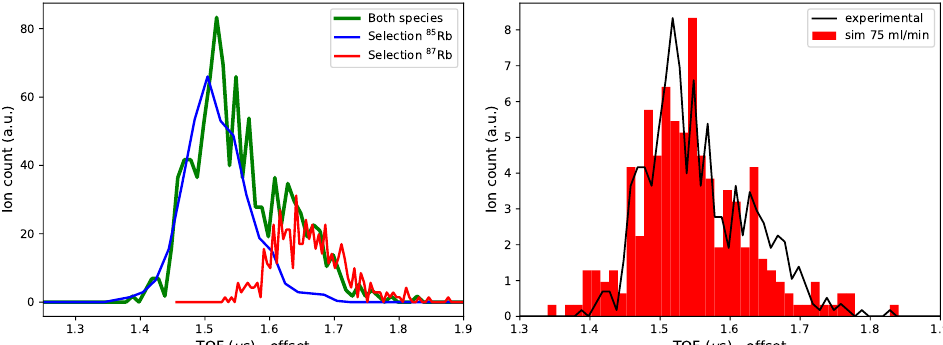
Figure 6. ( Left ) Time-of-flight distribution of rubidium ions behind the RFQ cb in three configurations: without any selection from the QMF (green); with QMF selecting 85 Rb + (blue); with QMF selecting 87 Rb + (red). The blue and red curves are normalized to 85,87 Rb relative abundance. ( Right ) Compari- son of the simulated (red) TOF distribution of a 85 Rb + - 87 Rb + mixture with 75 mL/min helium flow rate to the experimentally measured one